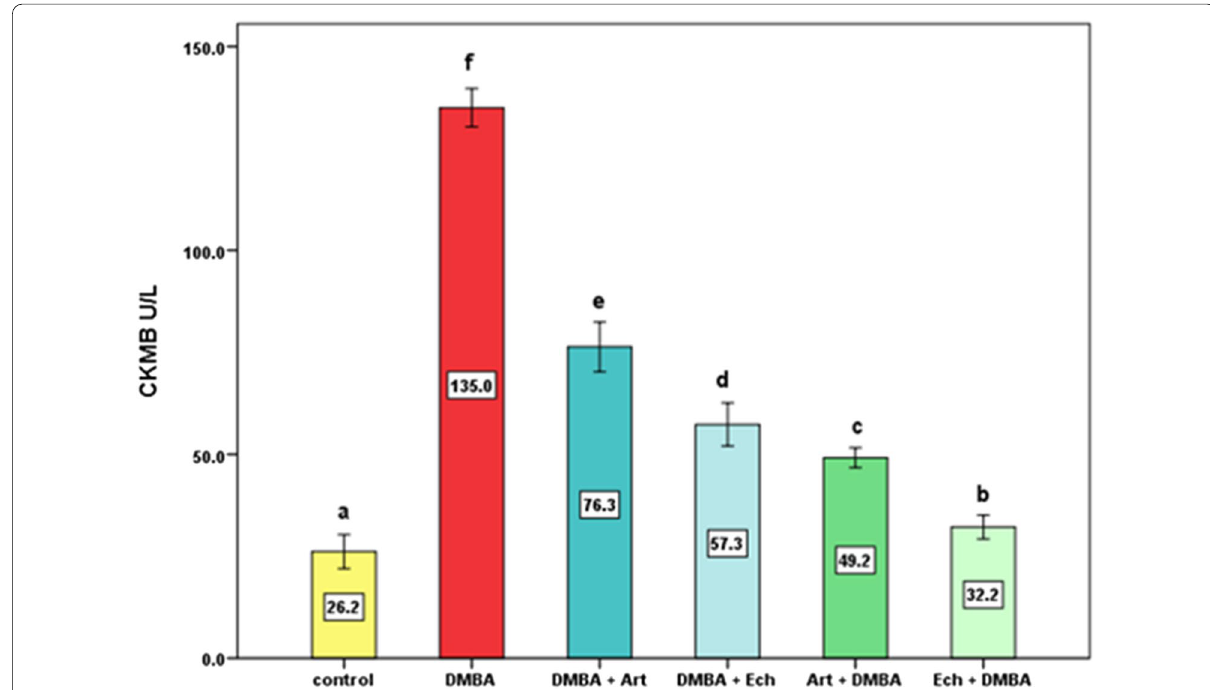
Fig. 4 Effect of treatment or protection with Artemisia or Echinacea on serum Creatinine Kinase isoenzyme MB (CKMB) activity (U ∕ L) in DMBA‑administered rats of all experimental groups. Values with different letters above columns are considered significantly different ( P ˂ 0.05). Values with same letters above columns are considered non‑significantly different ( P ˂